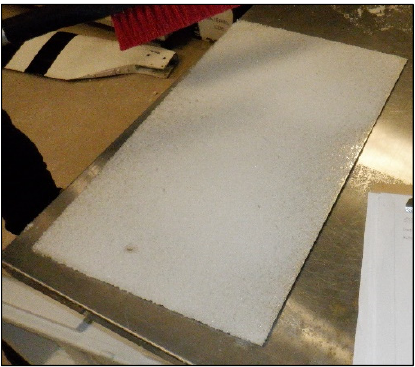
Figure 7. Partially melted and refrozen snow over aluminum reference plate of 30 cm by 50 cm.